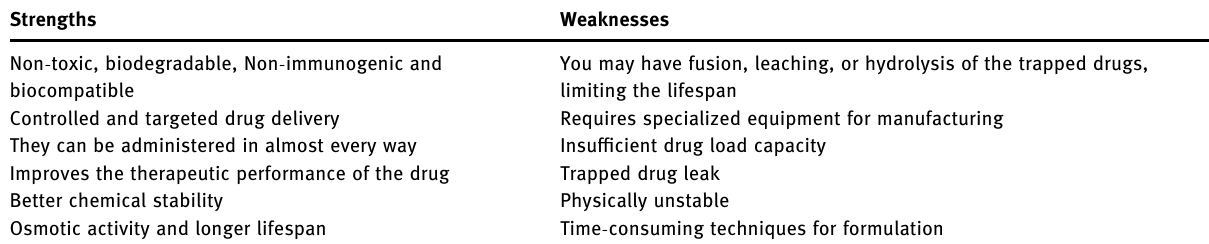
Table 7: Strengths and weaknesses of the niosomes [ 15 ]